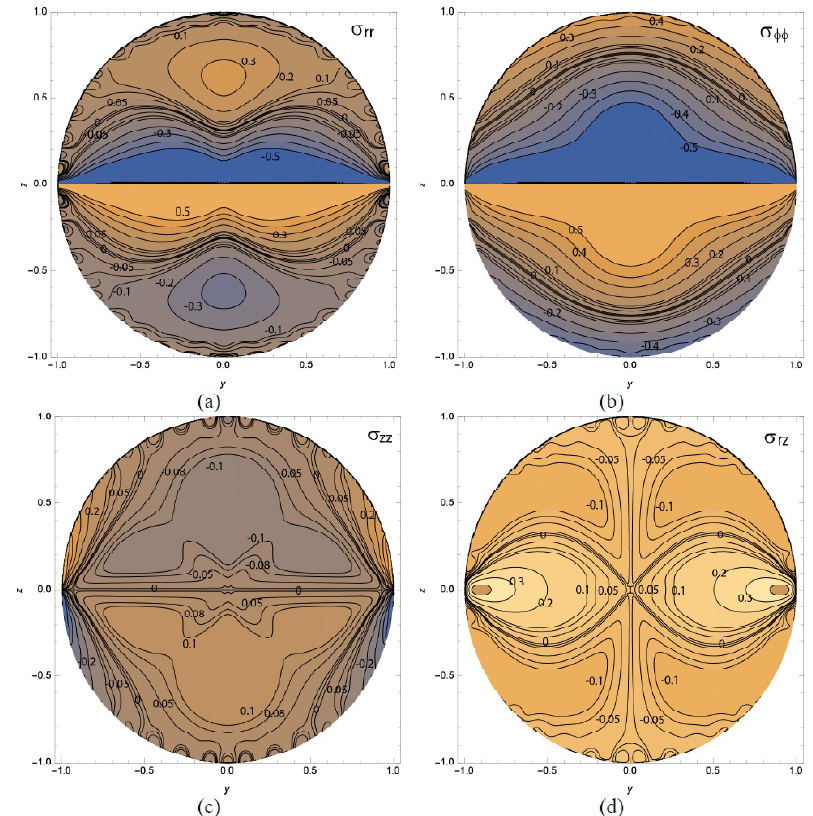
Fig. 6. Maps of the cylindrical stress components in the JP, consisting of two equal hemispheres with equatorial position ( z =0) of the interface. The stress values are given in units of G  *(1+  )/(1-  ), where the eigenstrain  * is attributed to the upper hemisphere. The map coordinates are normalized to the JP radius a . The calculations are made for the material with 